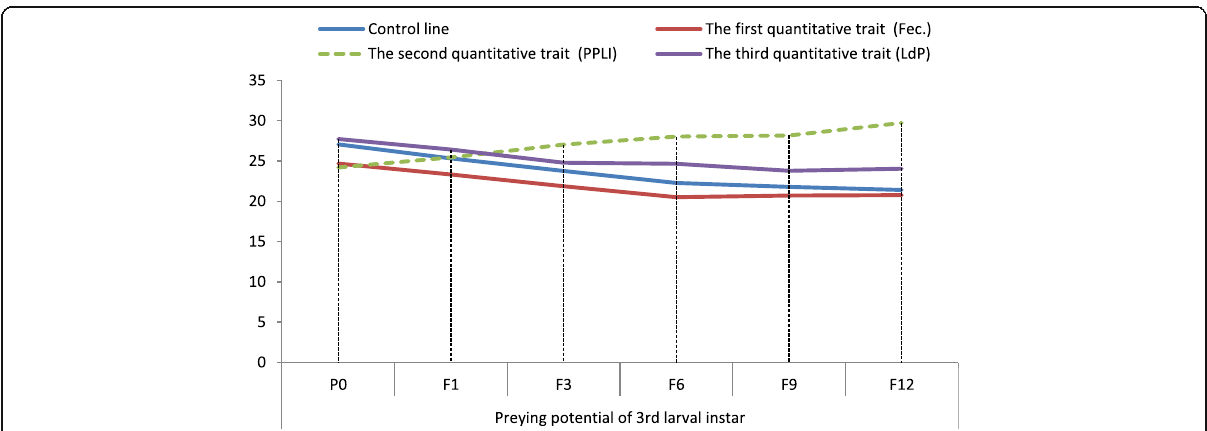
Fig. 2 Changes in the preying potential of 3 rd larval instar ( P. citri nymphs/day) according to the change of genetic improved